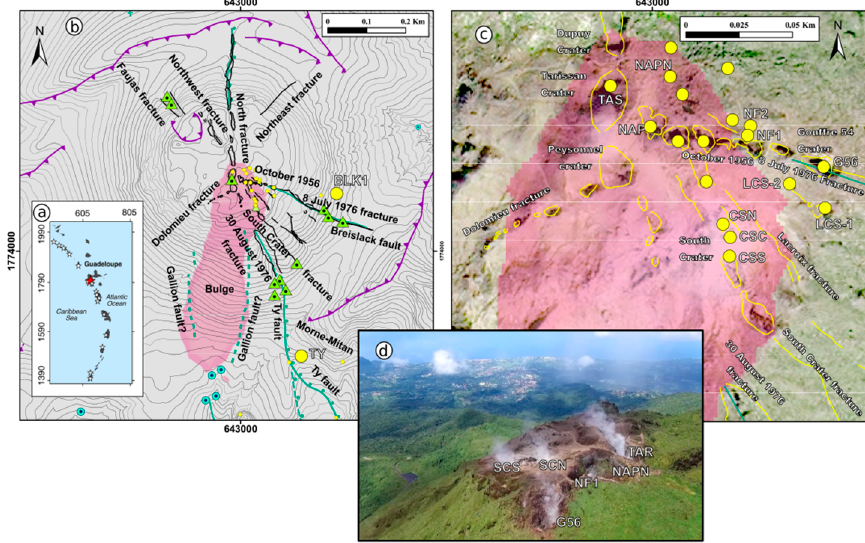
Figure 1. ( a ) Map of the Lesser Antilles volcanic arc; ( b ) main structures and manifestations of the hydrothermal system at La Soufri è re volcano showing the locations of thermal springs (blue circles), sites of exurgence of pressurized hydrothermal fluid (green triangles) during 1797–98, 1836 and 1976–77 phreatic eruptions [6,29], the main faults (blue-green), historical eruptive fractures and craters (black) and collapse structures (purple triangle on trace), the region of highest electrical conductivity ( > 1 S / m, light purple area) determined by Rosas-Carbajal et al. [29], active fumaroles (small and big yellow circles), 10 m DEM from GeoEye image, Latitude Geosystems; ( c ) 1 m resolution orthophoto (GeoEye) of the lava dome showing the main active fumaroles of the summit area (yellow circles) TAS: Tarissan crater; NAPN: Napol é on Nord; NAP: Napol é on 1 NPE1: Napoleon Est 1; NPE2: Napol é on Est 2; CS: Crat è re Sud, which is divided into northern (CSN), central (CSC) and southern (CSS) vents; G56: Gou ff re-56; LCS: Lacroix Sup é rieur, that is divided into LCS-1 and LCS-2; BLK1: Breislack fumarole; TY: Morne-Mitan fumarole along the Ty fault; ( d ) aerial photo of La Soufri è re lava dome (October 2016) showing vegetation impacted by prolonged H 2 S- and HCl-rich acid gas emissions, photo taken by A. Anglade, OVSG-IPGP, with a drone from OBSERA and with permission by the Parc National de Guadeloupe).